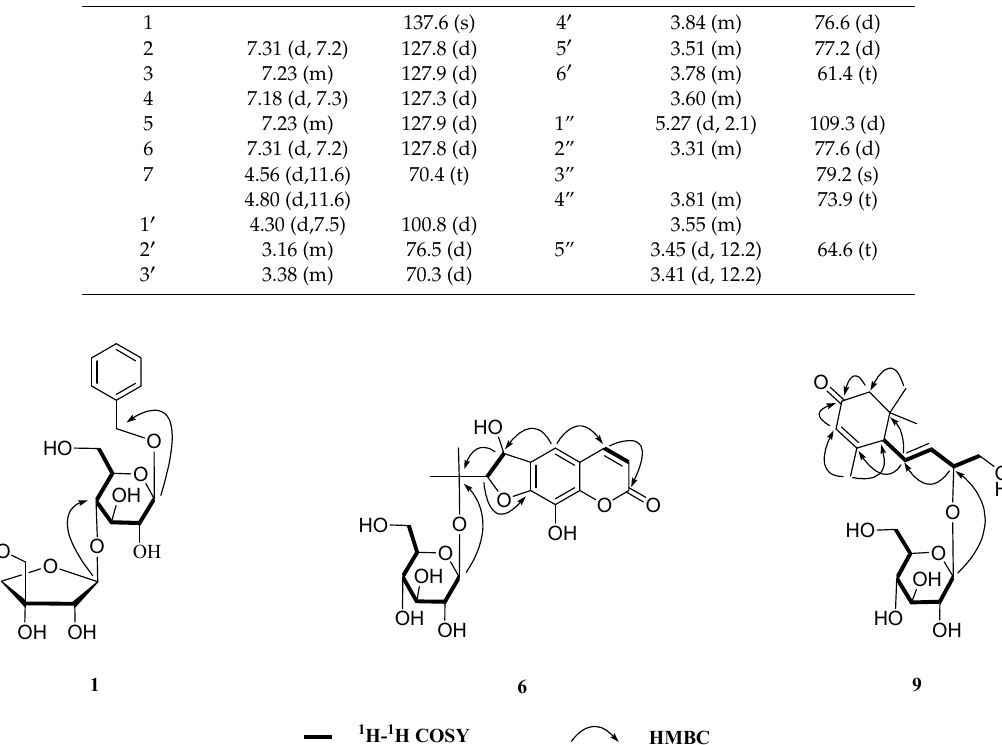
Figure 2. Some key HMBC and 1 H– 1 H COSY correlations of 1 , 6, and 9.